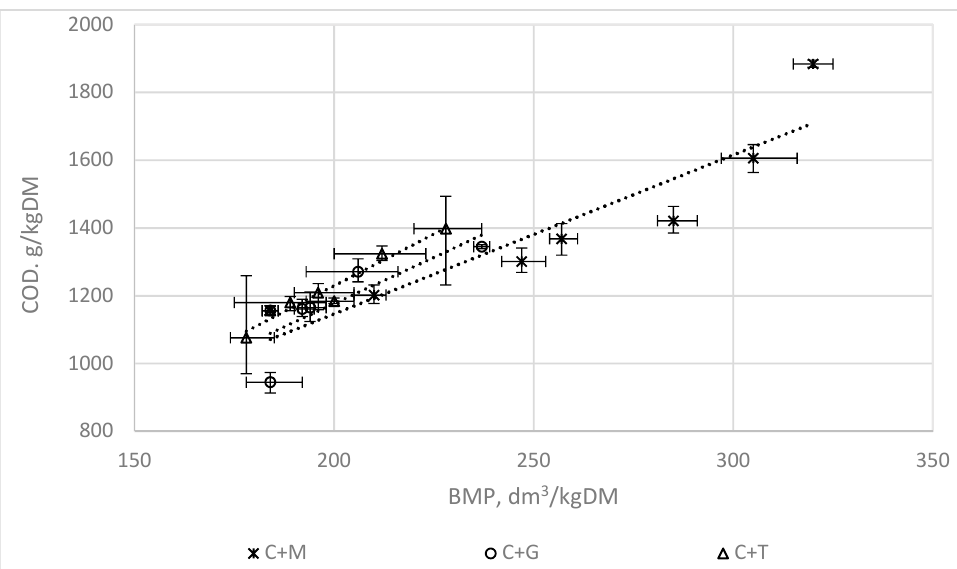
Figure 9 . The correlations between the VS index and the BMP . Table 2 presents the linear functions describing the correlations between these indices and the coefficients of determination R 2 . Table 2. The functions describing the correlations between the AT4, COD, and VS indices, and the BMP .